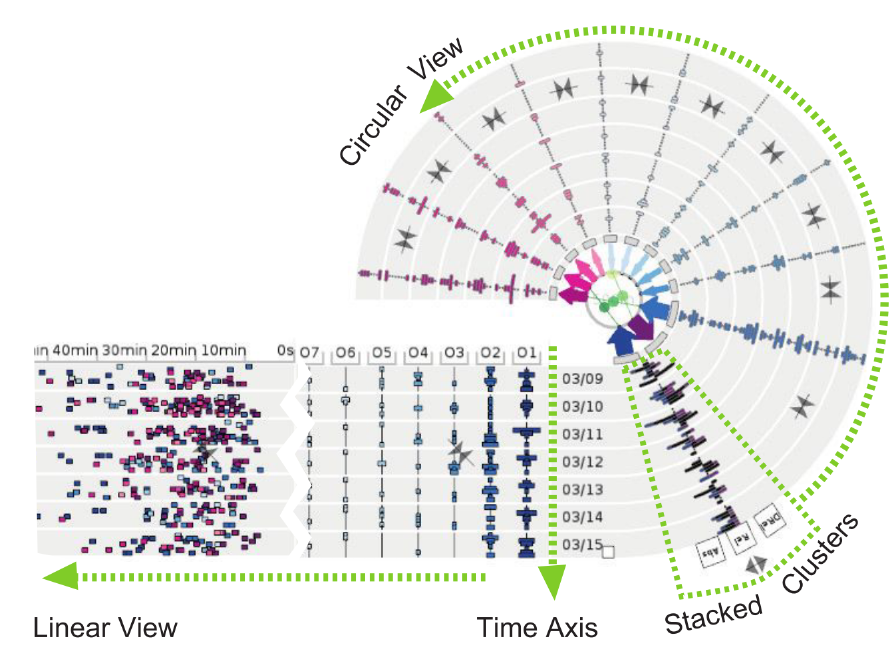
Figure 19. The OD-Wheeltechnique for exploring origin-destination patterns from trajectory data